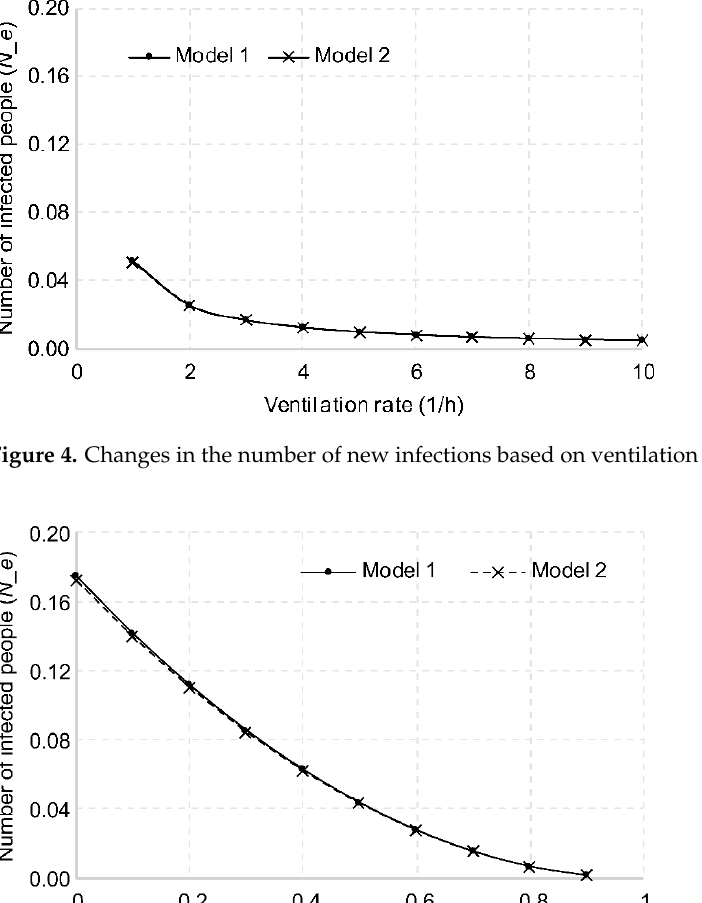
Figure 4. Changes in the number of new infections based on ventilation rate.